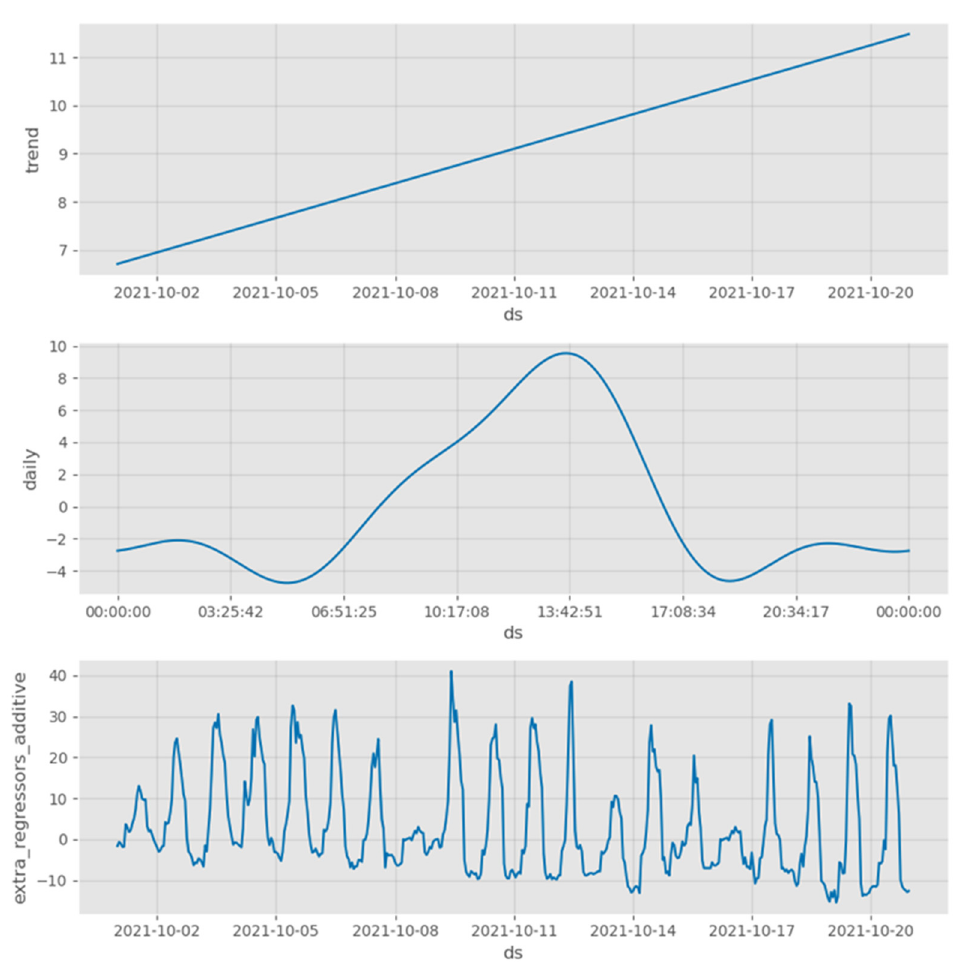
Figure 8. Results of training phase of Facebook Prophet algorithm for BEE_OUT variable.